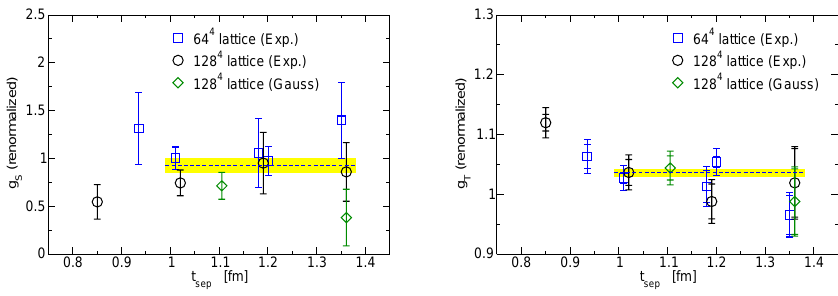
Figure 2: t sep dependence of the renormalized g S (left) and g T (right). The horizontal axis de- notes the source-sink separation t sep in physical unit. The inner and outer error bars represent their statistical and total uncertainties, respectively. The rest is the same as in Fig. 1. These figures are reprinted from Ref.